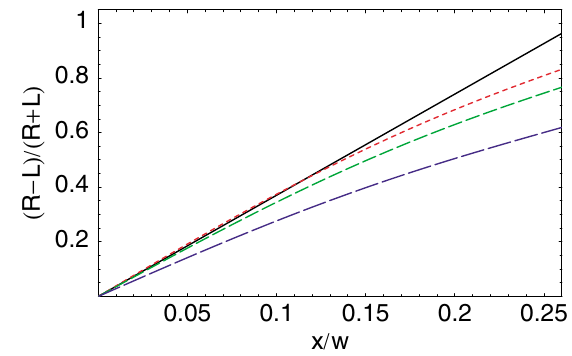
(cid:3) 0 , (cid:7) =b (cid:3) 0 : 2 . FIG. 7. (Color) Same as Fig. 6, but with beam-size corrections x y for a flat beam with (cid:7)